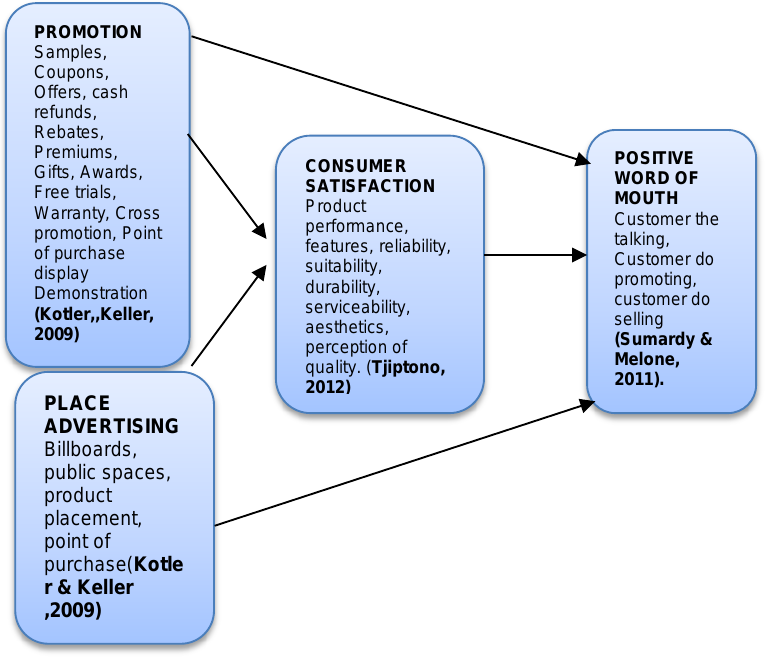
Figure 1: Conceptual Frame Work; Source: Authors